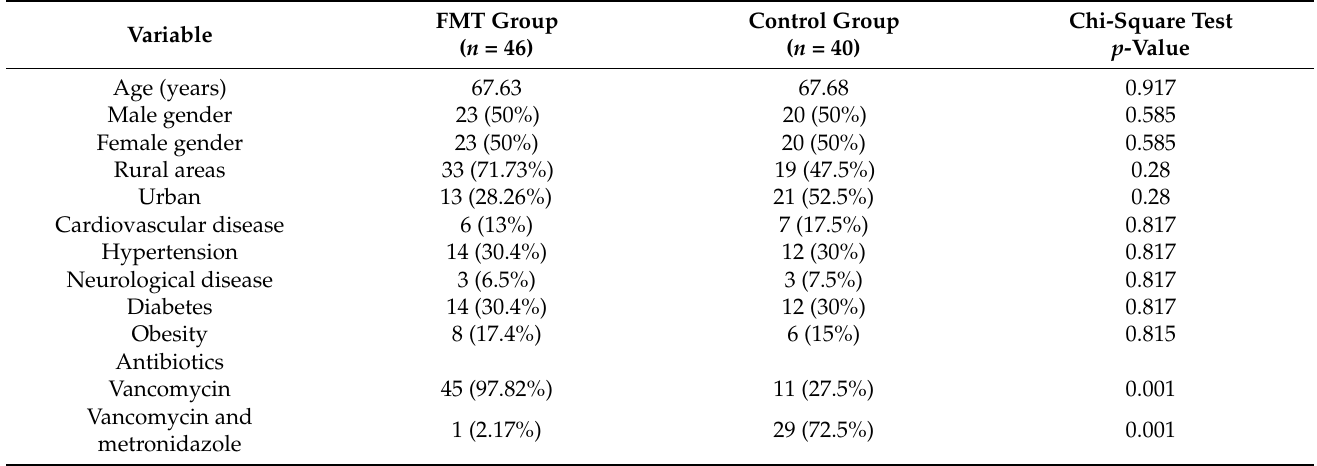
Table 1. Demographic and clinical characteristics of the